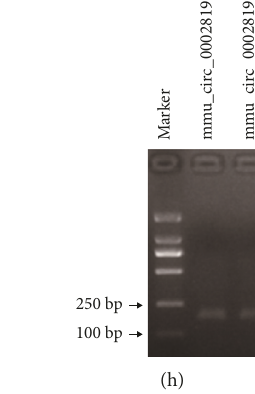
Figure 3: Characterization of hsa_circ_0046060 in hUMSCs and hUMSC-EXOs. (a) Blast analysis to explore homology between human circRNA sequence XXX and mice sequence. (b, d) Bodyweight of pregnant and fetal mice in control and GDM groups as determined by an electronic scale. (c, e) Fasting blood glucose level of pregnant and fetal mice in control and GDM groups as determined using blood glucose test strips. (f) Expression levels of exosomal mmu_circ_0002819 in control and GDM mice as determined using RT-qPCR. (g) Inhibitory effects of three siRNA-mediated knockdown of mmu_circ_0002819 as determined by RT-qPCR assay. (h) Effect of lentiviral sh- mmu_circ_0002819 on mmu_circ_0002819 expression in hUMSCs and hUMSC-EXOs as evaluated by RT-qPCR. (i) Sanger sequence analysis showing the splicing site. (j) RT-qPCR products were evaluated using agarose gel electrophoresis. ∗ P < 0 . 05, ∗∗ P < 0 .